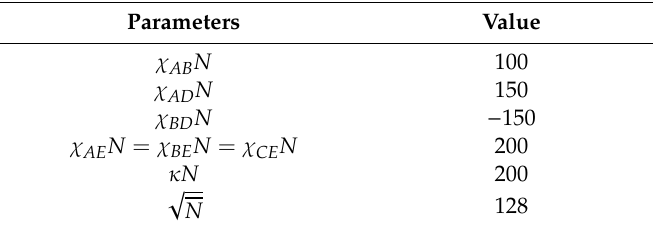
Table 1. Summarized simulation parameters for the system of N = 128. A, B, C, D, and E represent protected site, deprotected site, backbone, developing solvent, and air,